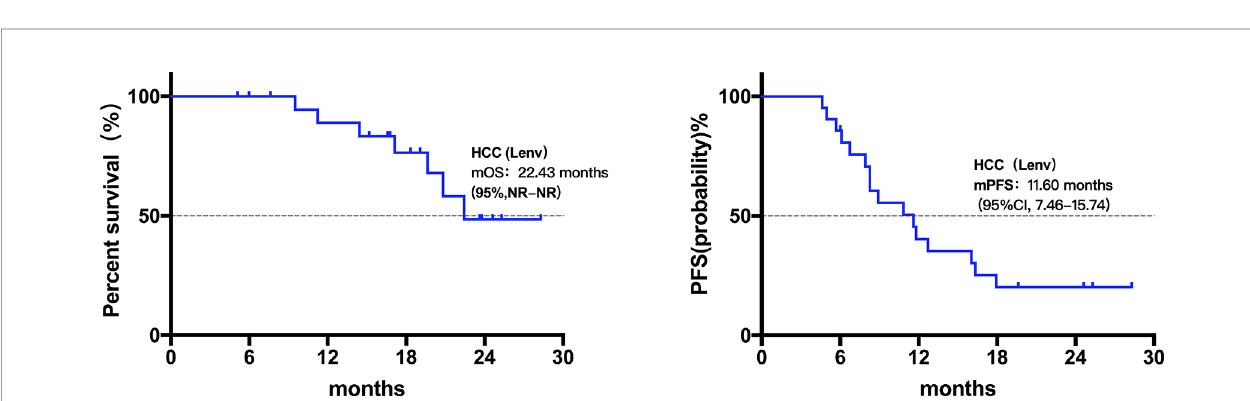
FIGURE 1 | Kaplan-Meier estimates of overall and progression-free survival in all patients. The mOS of all patients was 22.43 months (95% con fi dence interval was not reached; range: 4.20-28.30 months), and the mPFS of all patients was 8.93 months (95% CI, 6.76-11.10; range, 3.20-28.30 months).